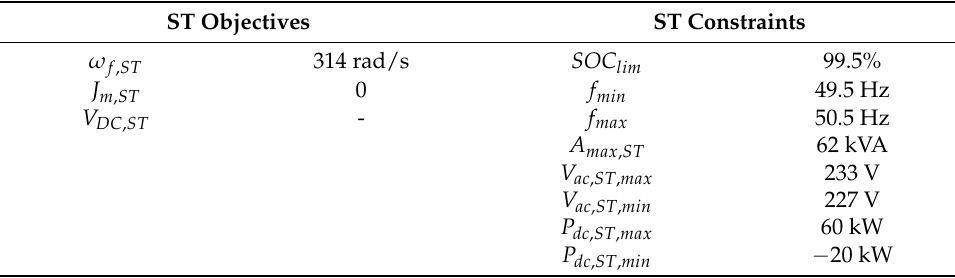
Table 6. ST Controller parameters. Slack mode.